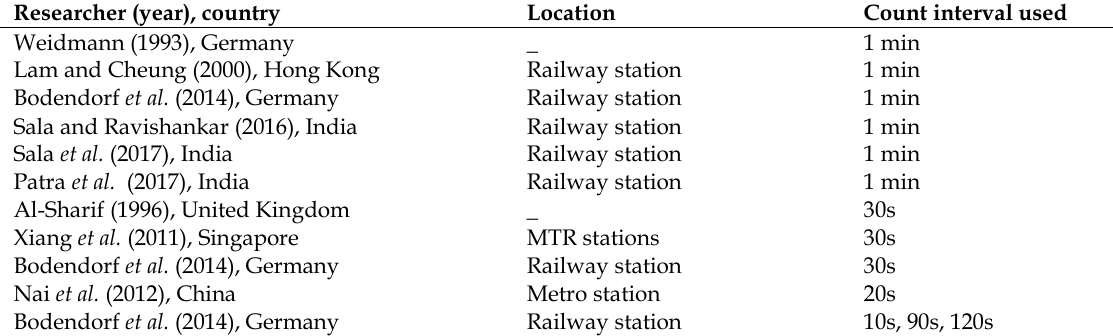
Table 2. Data Extraction Count Interval used in Different Studies on